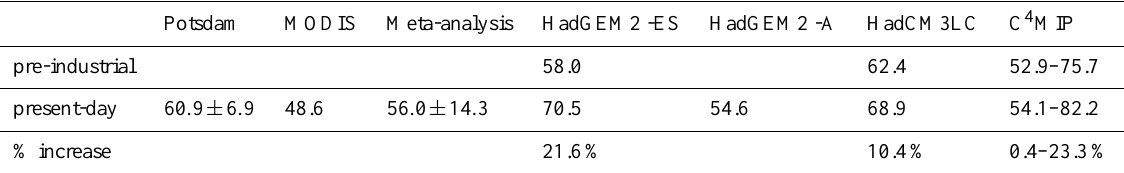
Table 2. Global total net primary productivity, NPP (GtC yr − 1 ) from observationally derived estimates (Potsdam dataset (Cramer et al., 1999), and MODIS), a model and observations meta-analysis (Ito, 2011) and global models. For the Potsdam dataset we quote the standard deviation, and for C 4 MIP we quote the range across the 11 models. The “-ES” and “-A” refer to the full Earth system, and to physical atmosphere-only configurations of